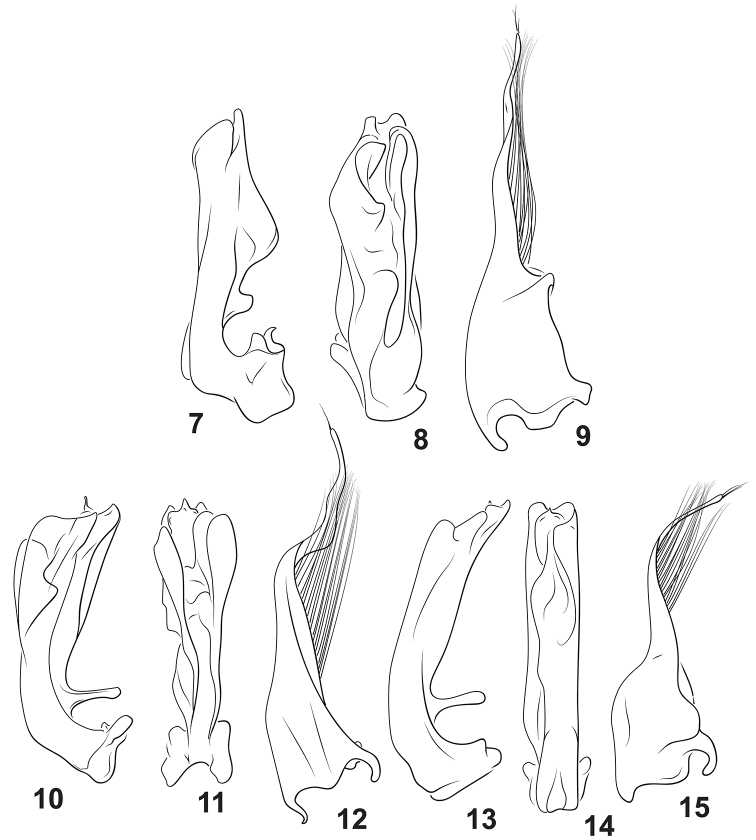
Agaporomorphus species, male genitalia. 7–9A.
grandisinuatus7 male median lobe, right lateral aspect 8 male median lobe, ventral aspect 9 male right lateral lobe, right lateral aspect 10–12A.
mecolobus10 male median lobe, right lateral aspect 11 male median lobe, ventral aspect 12 male right lateral lobe, right lateral aspect 13–15A.
dolichodactylus13 male median lobe, right lateral aspect 14 male median lobe, ventral aspect 15 male right lateral lobe, right lateral aspect.